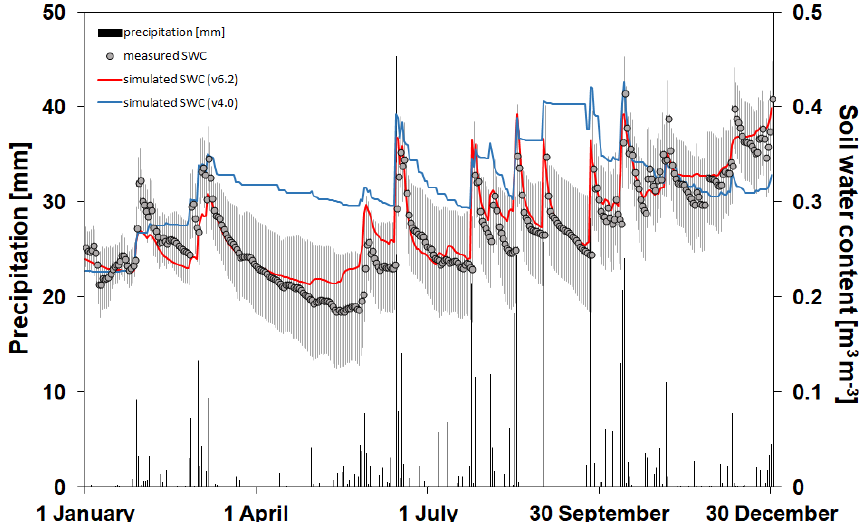
Figure 8. The simulated (blue line: v4.0; red line: v6.2) and observed (grey dots) soil water content values at 10cm depth (right y axis) with the daily sums of precipitation (left axis; black columns) during 2020 at the Martonvásár lysimeter station. Vertical grey lines associated with the observations represent ± 1 standard deviation around the observations. The improved model clearly outperforms the earlier version in simulating soil water